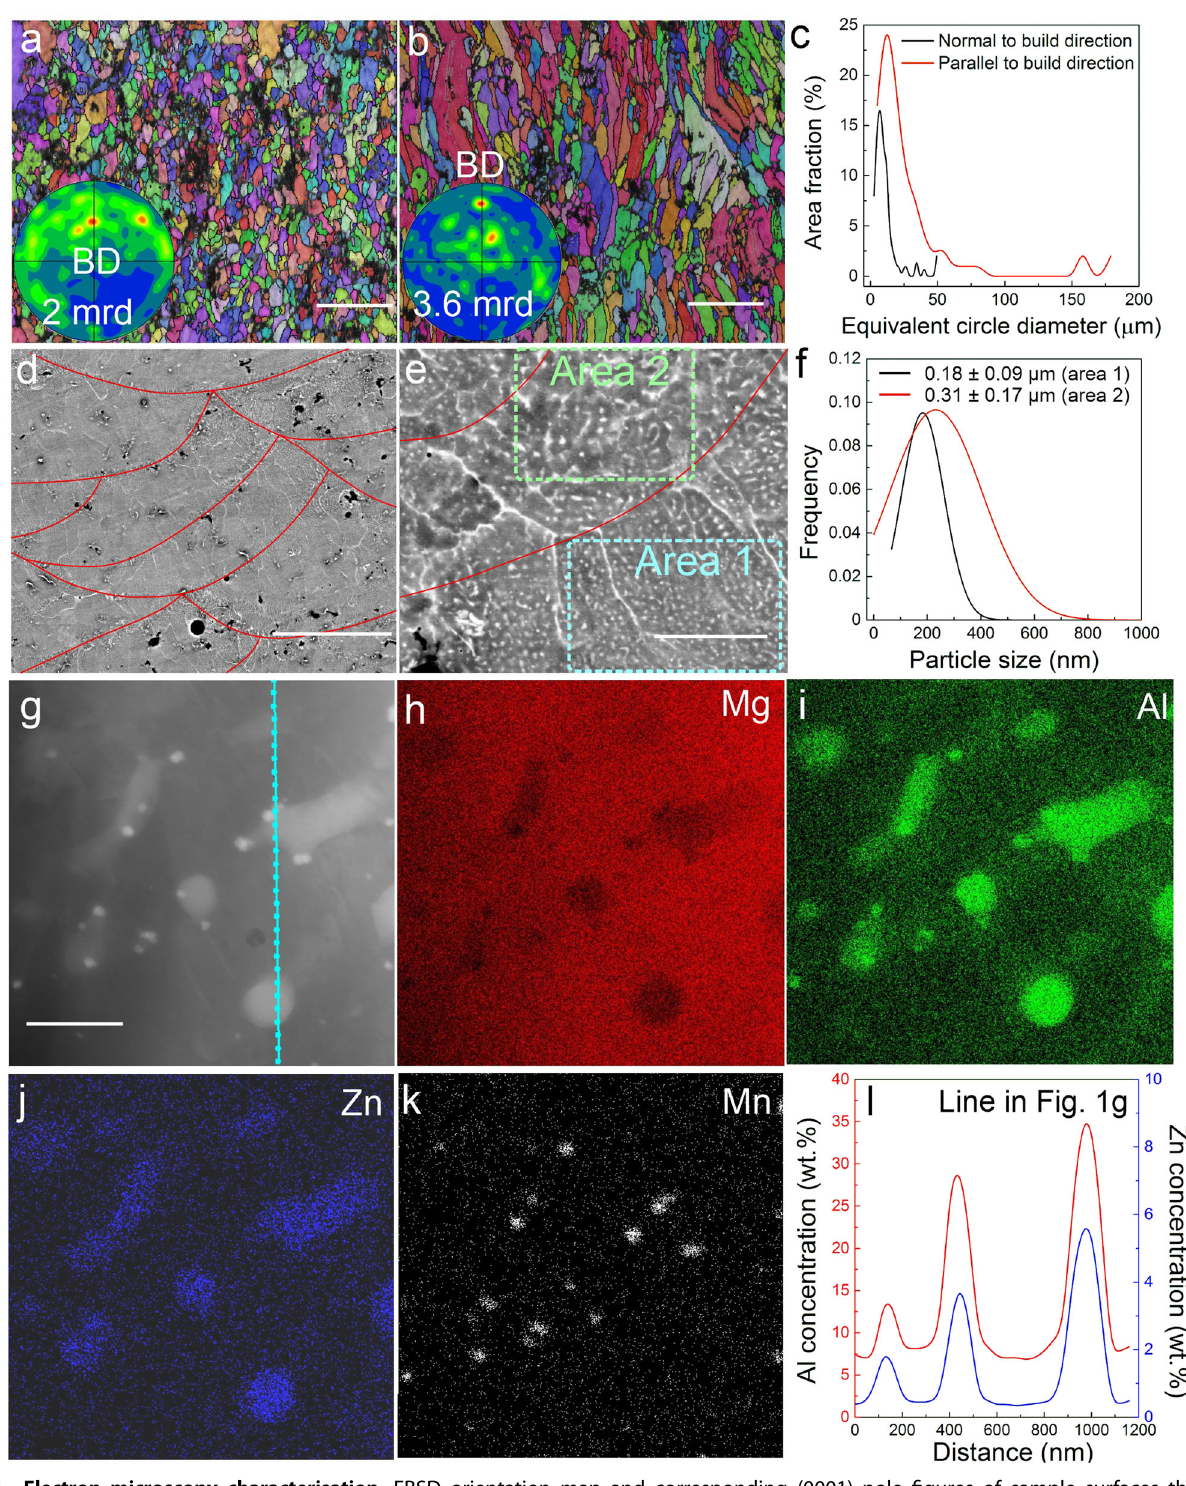
Fig. 1 Electron microscopy characterisation. EBSD orientation map and corresponding (0001) pole fi gures of sample surfaces that are a normal and b parallel to the build direction. c Histogram showing the distribution of grain size in a and b . Scanning electron microscopy (SEM) backscattered electron images (BSE) showing ( d ) melt pool at low magni fi cation and ( e ) ultra- fi ne particles dispersed within the melt pool and coarser particles between melt pools and grain boundaries. f Particle size distribution in Area 1 and Area 2 shown in e . g – k High- angle annular dark- fi eld scanning transmission electron microscopy (HAADF-STEM) and corresponding STEM energy-dispersive X-ray spectroscopy (EDXS) mapping showing ultra- fi ne particles and elemental distribution. l Pro fi le showing the concentration of Al and Zn along the line in g . Scale bars in a , b , d , e , and g indicate 50 µm, 50 µm, 50 µm, 5 µm, and 300 nm,